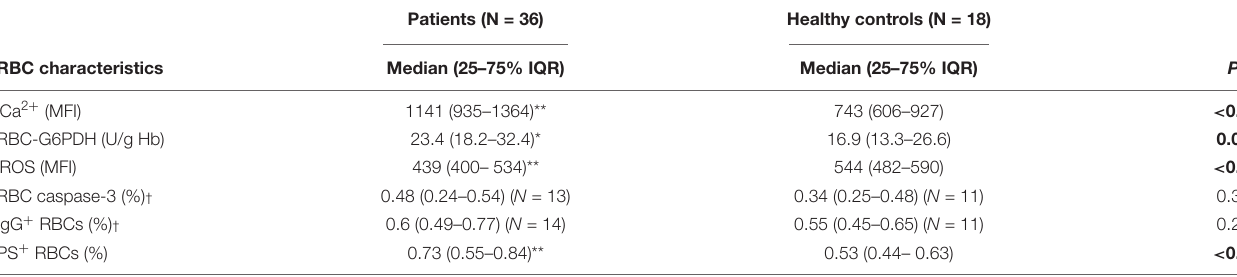
TABLE 2 | Red blood cell characteristics in SARS-CoV-2 patients and in healthy subjects.